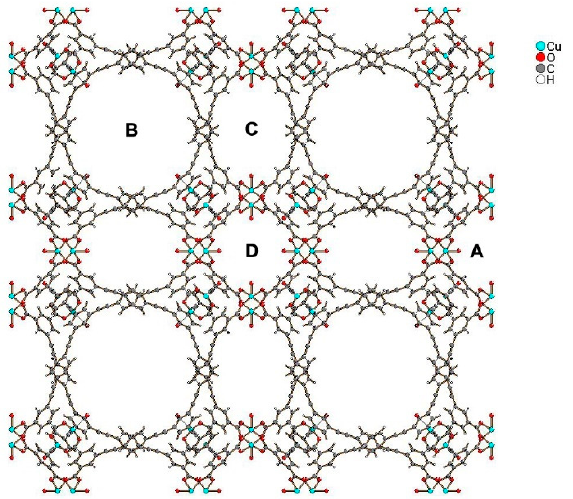
Figure 5. View of the structure of PCN-610/NU-100, where “A” shows paddle wheel Cu 2 (-COO) 4 units, and “B”, “C”, and “D” show three types of voids of different sizes present in the